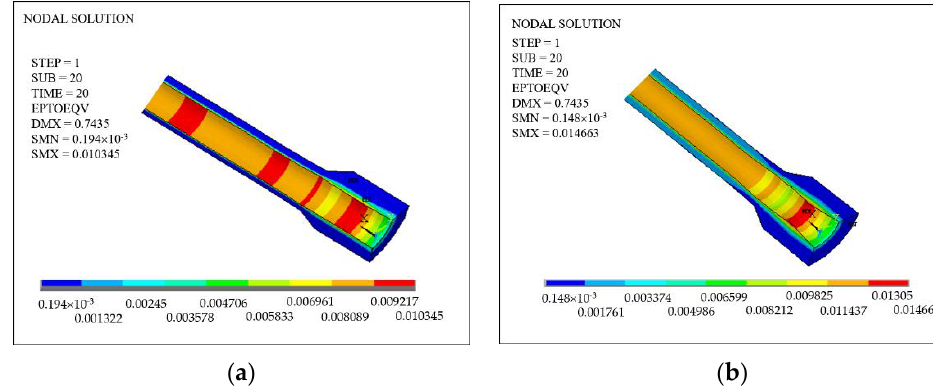
Figure 4. Finite element simulated von Mises strain contour of nozzle under mechanical and thermal loads. ( a ) Elastic analysis; ( b ) elastoplastic analysis.